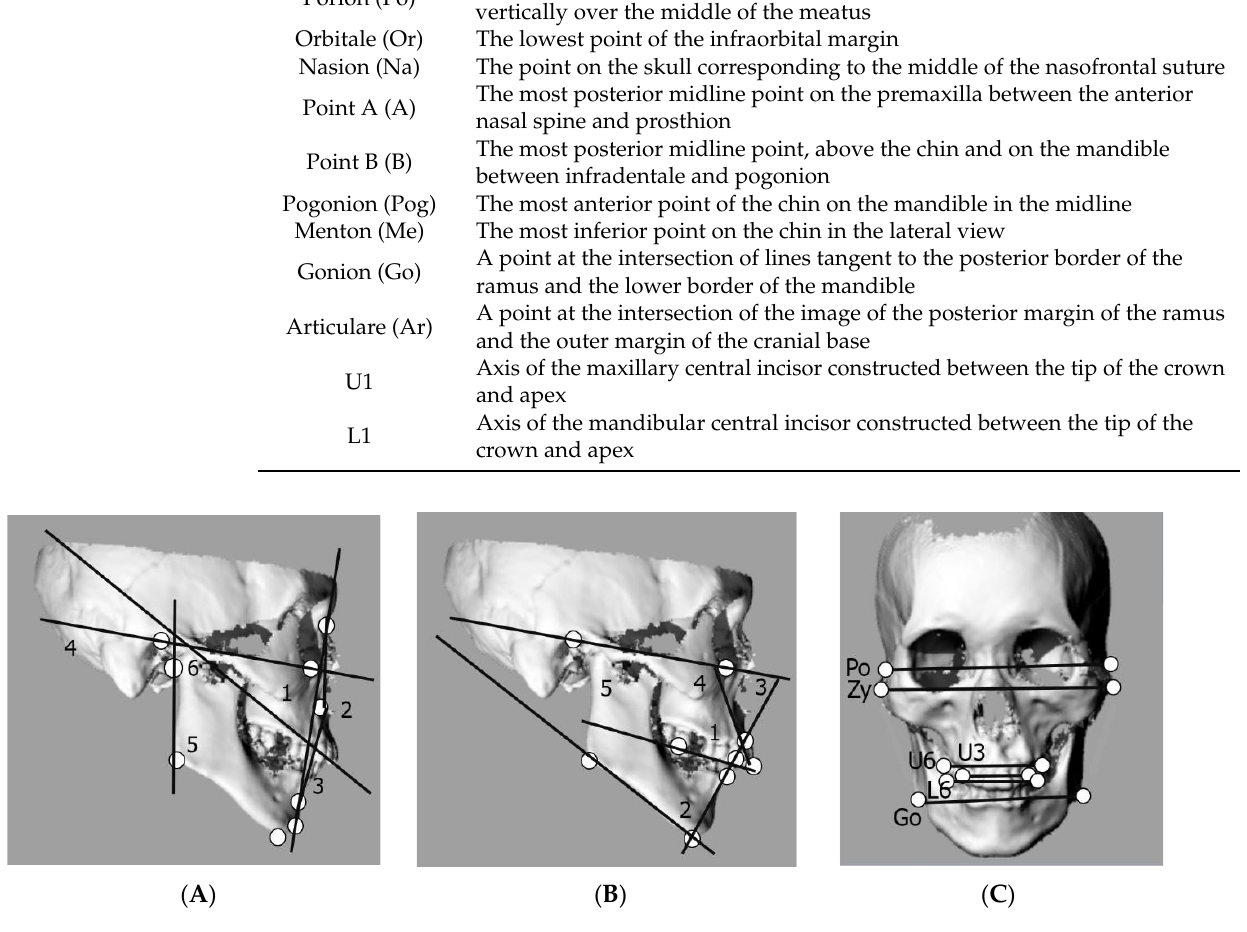
Figure 1. Measurement variables. ( A ) Skeletal angular measurements: 1, facial angle; 2, angle of convexity; 3, A-B plane angle; 4, mandibular plane angle; 5, gonial angle, 6; ramus plane angle to the Frankfort horizontal (FH) plane. ( B ) Dentoalveolar angular measurements: 1, interincisal angle; 2, L1 to mandibular plane angle; 3, Frankfort-mandibular incisor angle; 4, U1 to the FH angle; 5, occlusal plane angle to the FH plane. ( C ) Linear measurements related to the width of the jawbones,